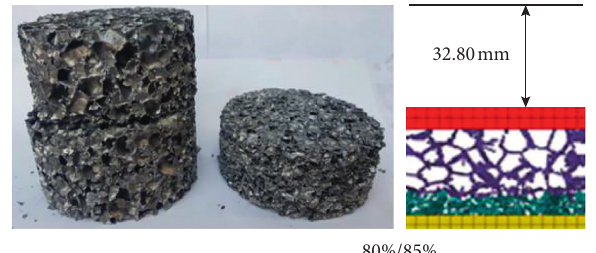
Figure 7: 80%/85% aluminum foam